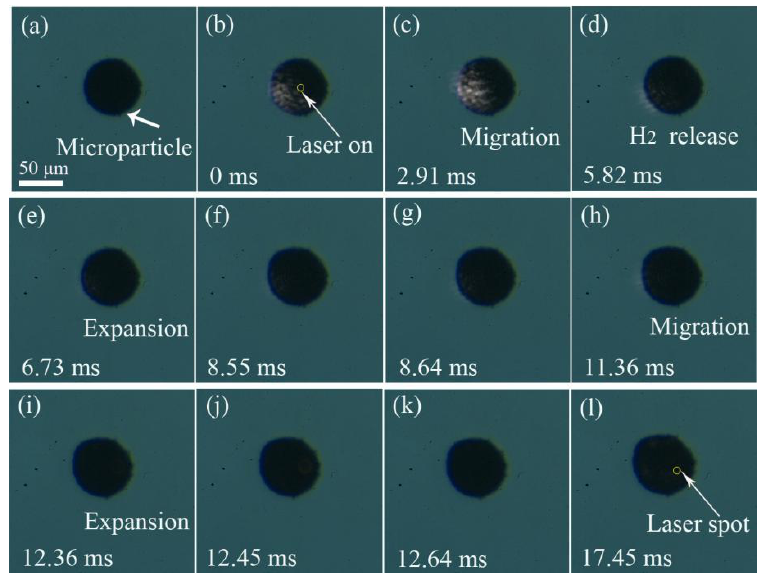
Figure 7. Representative snapshots of expansion and migration stage of individual Mg microparticle. (Images acquired from Supplementary Materials, Video S1, recording frame: 11,000 fps; exposure time: 99 μs). ( a ) Sample, ( b ) Laser on, 0 ms, ( c ) 2.91 ms, ( d ) 5.82 ms, ( e ) 6.73 ms, ( f ) 8.55 ms, ( g ) 8.64 ms, ( h ) 11.36 ms, ( i ) 12.36 ms, ( j ) 12.45 ms, ( k ) 12.64 ms, ( l ) 17.45 ms.